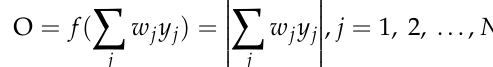
Table 3. Fuzzy rules for fault identification and trigger of protective relay.